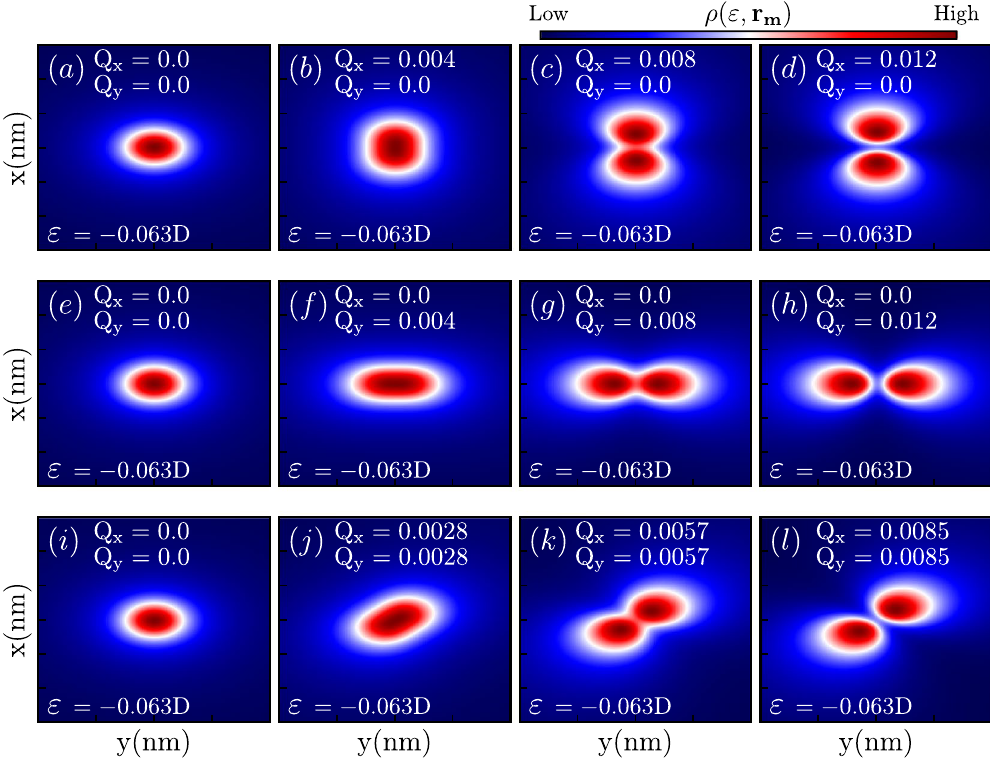
Figure 2. 2D LDOS maps for the case of a single impurity taken at fixed energy ε . Crossover from s – to p –type orbitals associated with moving from Dirac ( Q = 0) to Weyl ( Q ≠ 0) regime is clearly